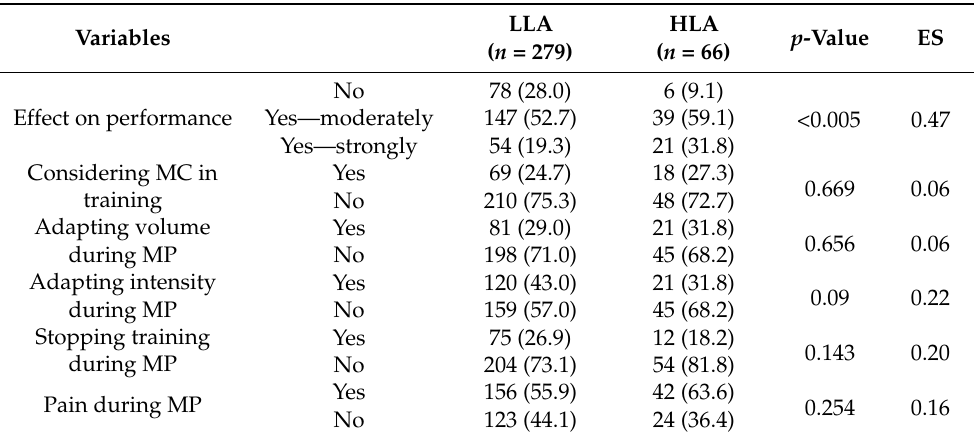
Table 4. Influence of the menstrual cycle (MC) on training habits, related to different athletic levels with contraceptive hormones ( n =